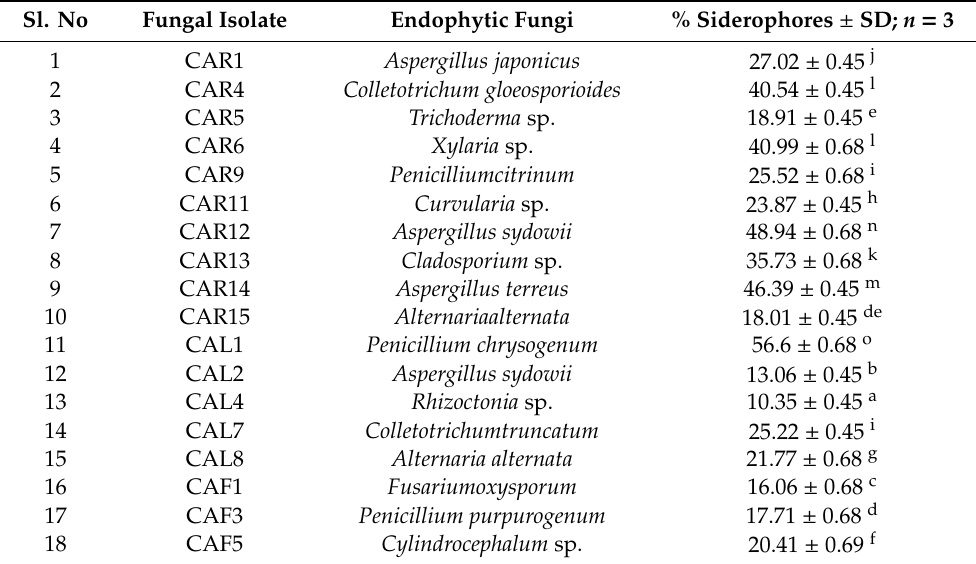
Table 2. Estimation of siderophore content produced by endophytic fungi of Cymbidium aloifolium using Chrome Azurol S (CAS) liquid